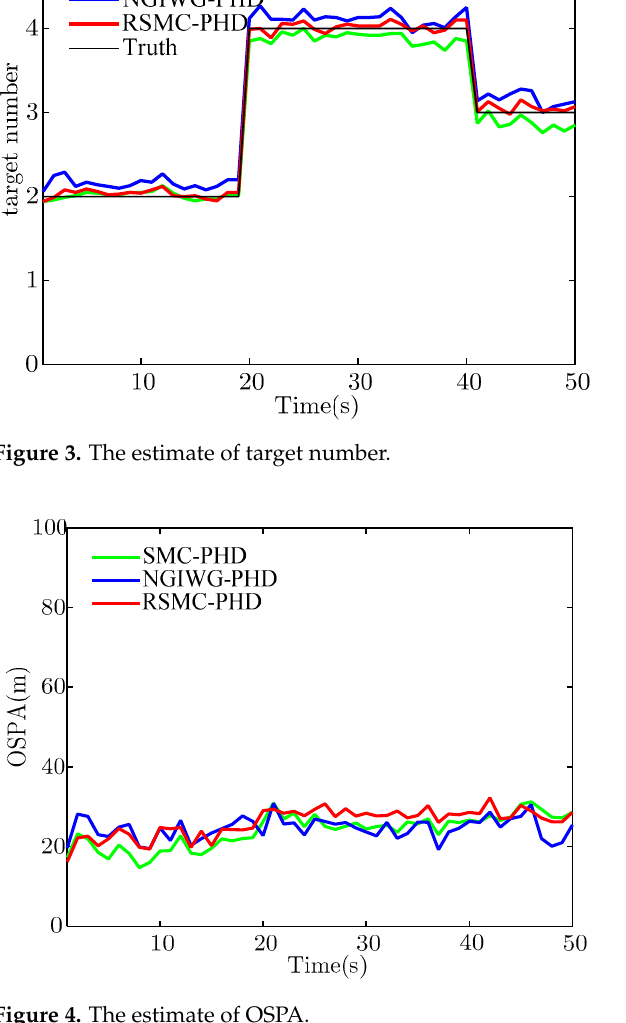
Figure 4. The estimate of OSPA.